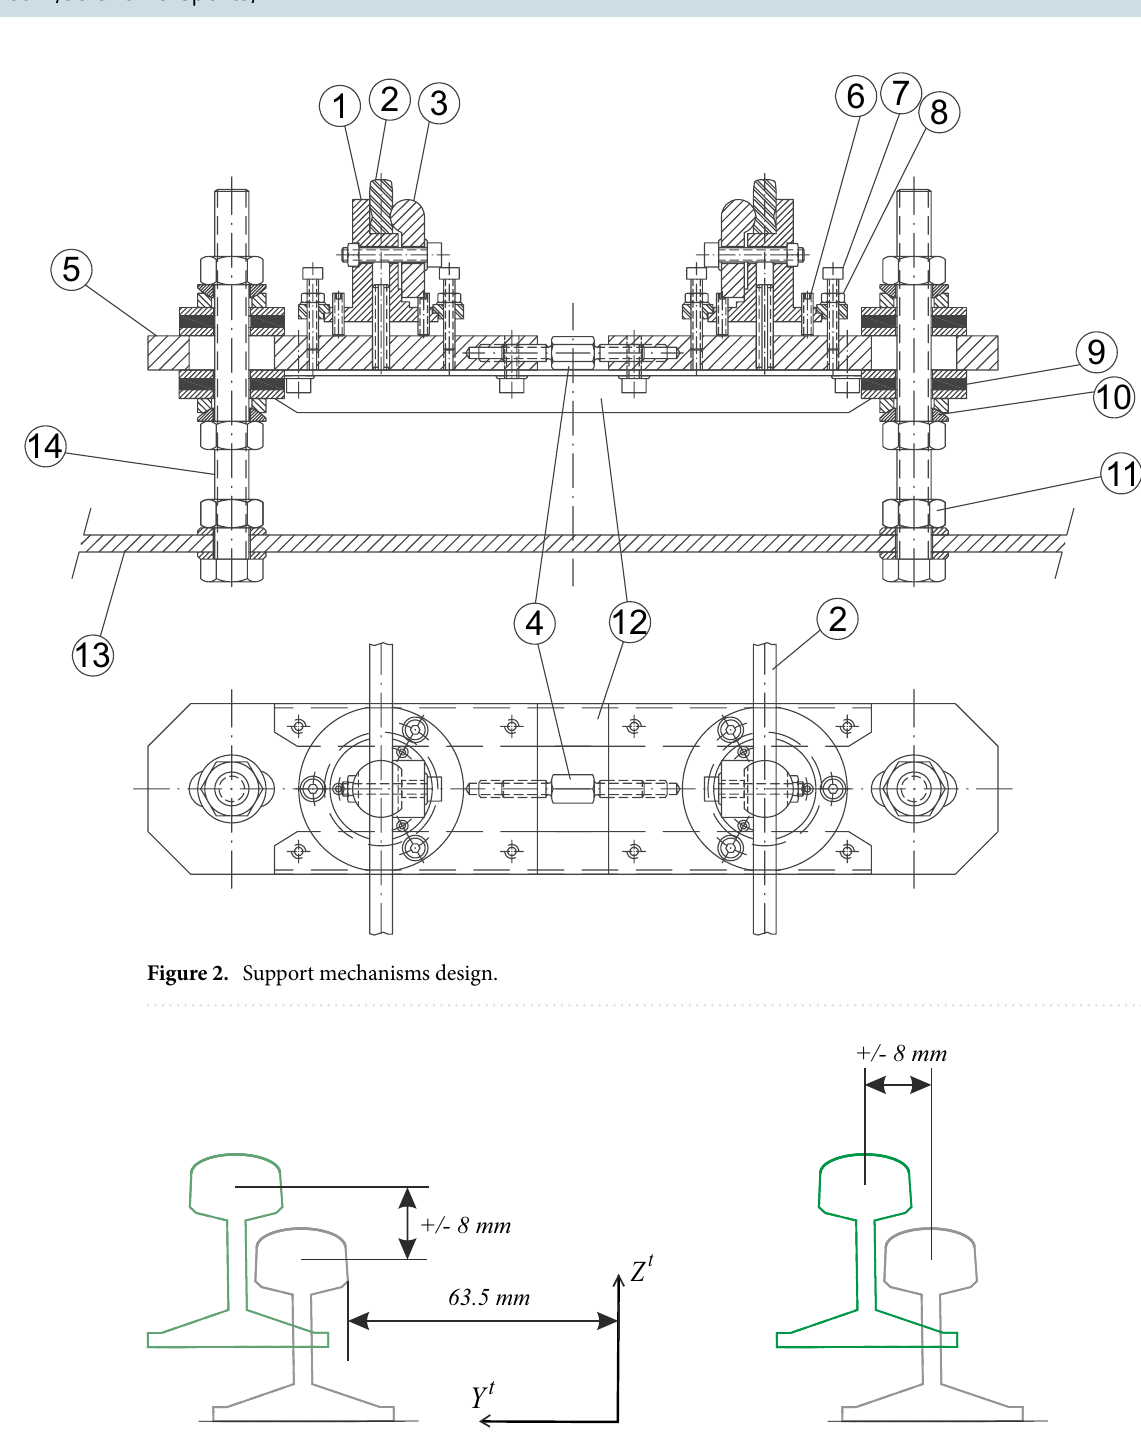
Figure 3. Displacement of the